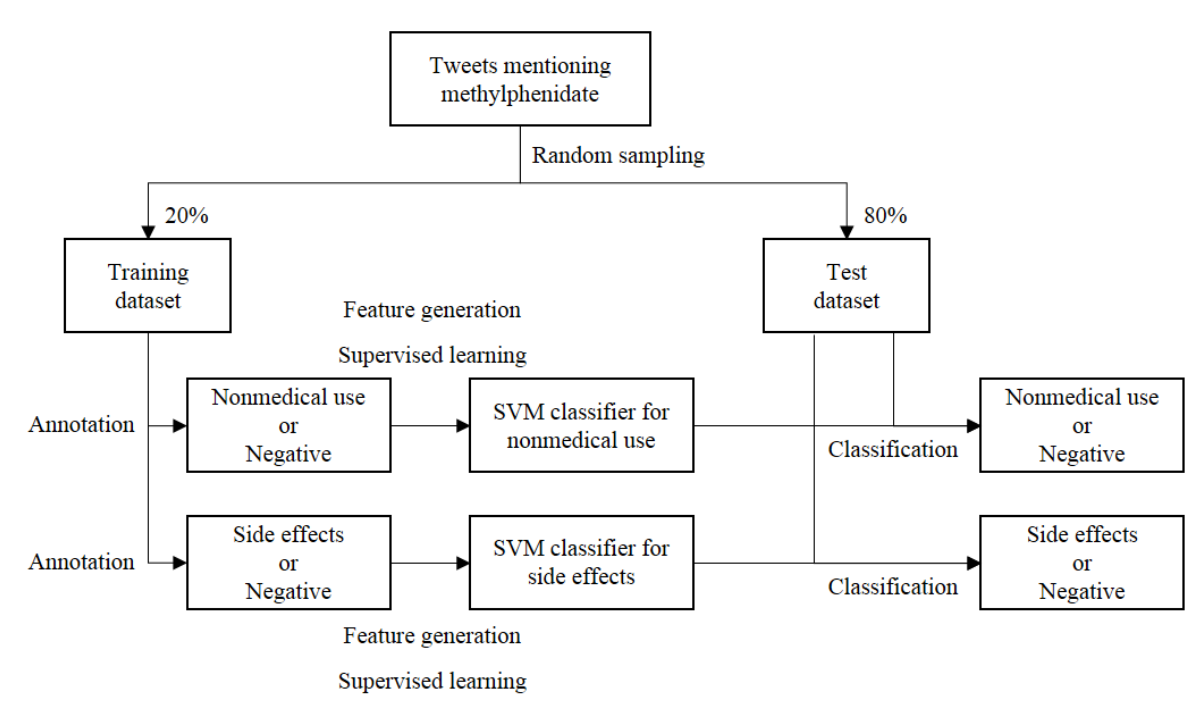
Figure 1. Schematic diagram of the study design. SVM: support vector